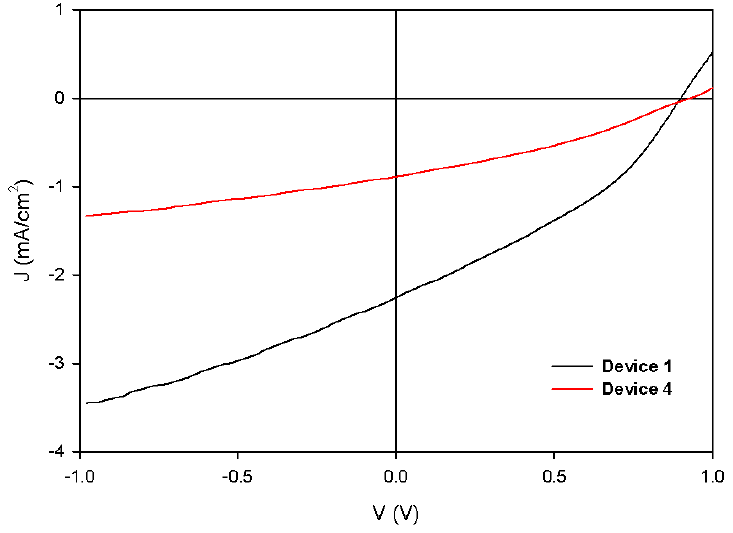
Figure 6. I-V-curves for the two different device types, Device 1 and Device 4 .